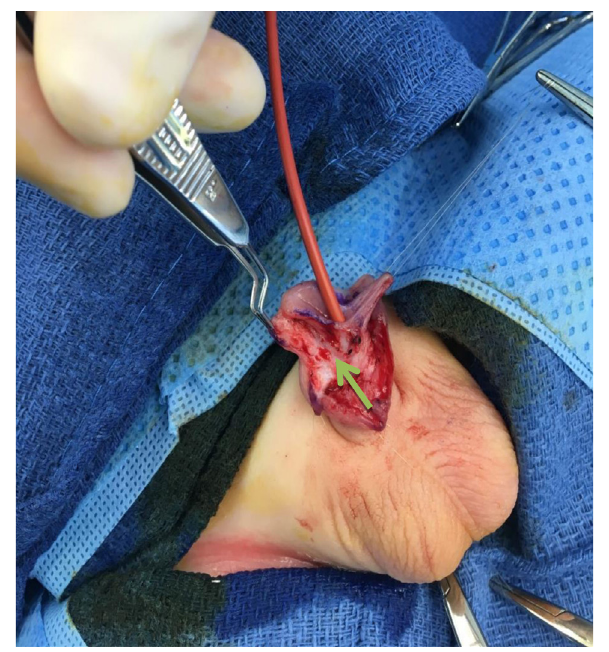
FigUre 2 | Intraoperative view of the urethral plate dissection. Note the clear delineation of the lateral extension of the urethral plate (green arrow). A traction suture on the inframeatal flap allows for identification of the tissue planes between urethra and glans.